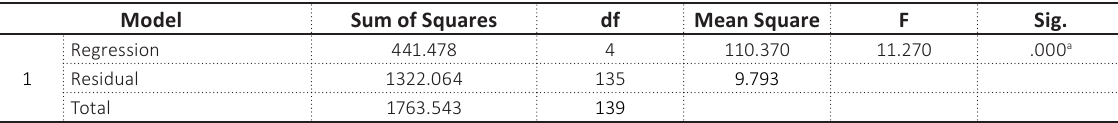
Table 6. ANOVA b